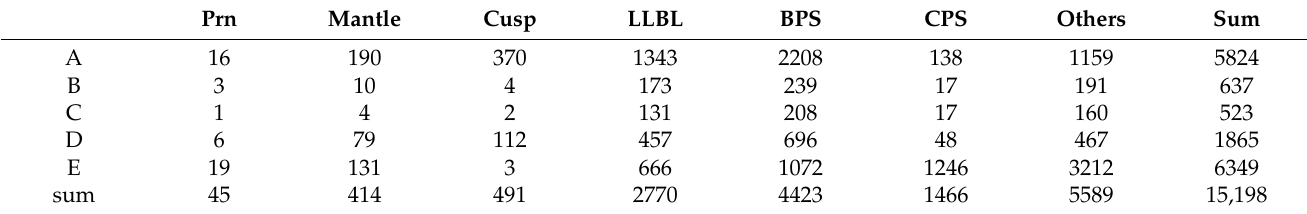
Table 1. Statistics of ion upflows in the geomagnetic latitude range of 70–80 ◦ on the dayside region of northern hemisphere in January and July 2005. From left to right, the source region of the magnetosphere is, successively, polar rain (prn), plasma mantle (mantle), polar gap (Cusp), low- latitude boundary layer (LLBL), plasma sheet boundary layer (BPS) and central plasma sheet (CPS), the same below, while the others are the events with no clear magnetospheric source region, and sum is the total